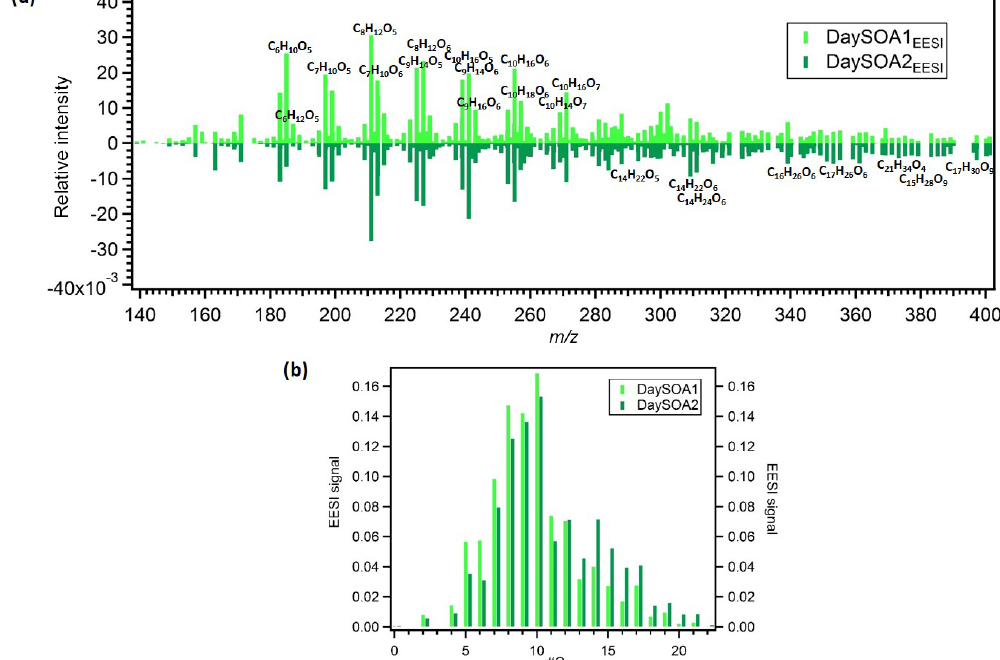
Figure 5. (a) Mirrored mass spectra of EESI DaySOA1 and DaySOA2. Factor profiles are first weighted by their molecular weight to represent equivalent mass concentrations (ags − 1 ) and then normalized such that the sum of each spectrum is 1. (b) Histogram of normalized profile signals distributed across bins of carbon atom